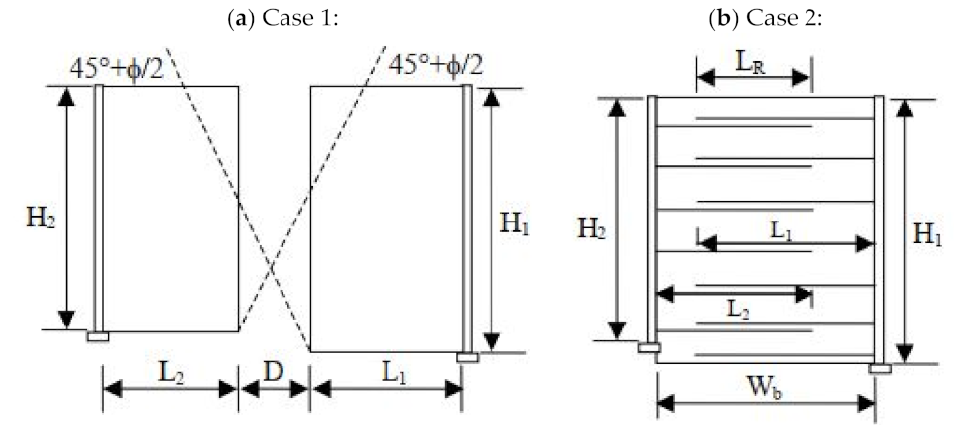
Figure 1. Back-to-back reinforced soil wall definitions: Case 1 ( a ) and Case 2 ( b ). (Source: FHWA [2]).